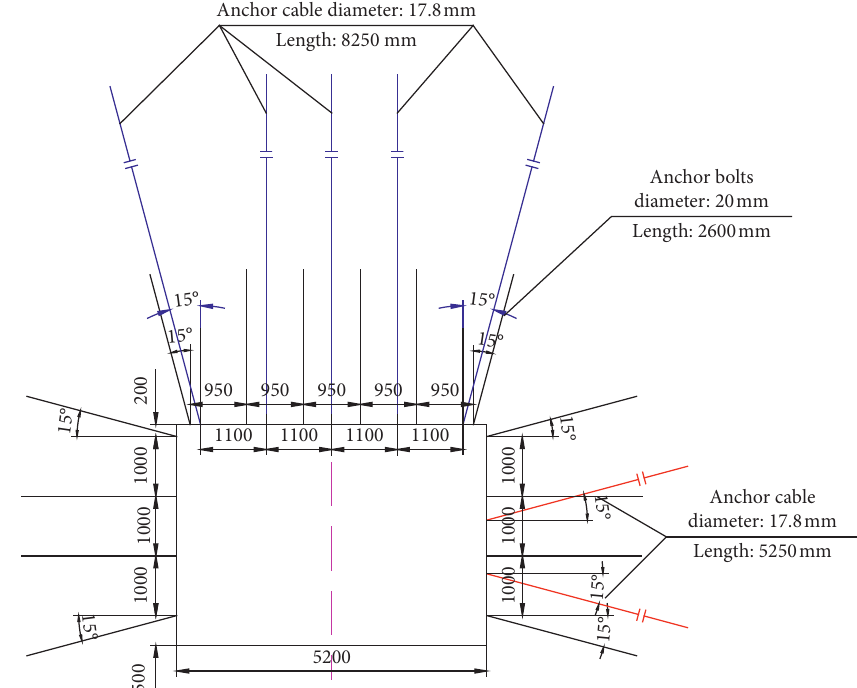
Figure 5: Support scheme of the gob-side entry.